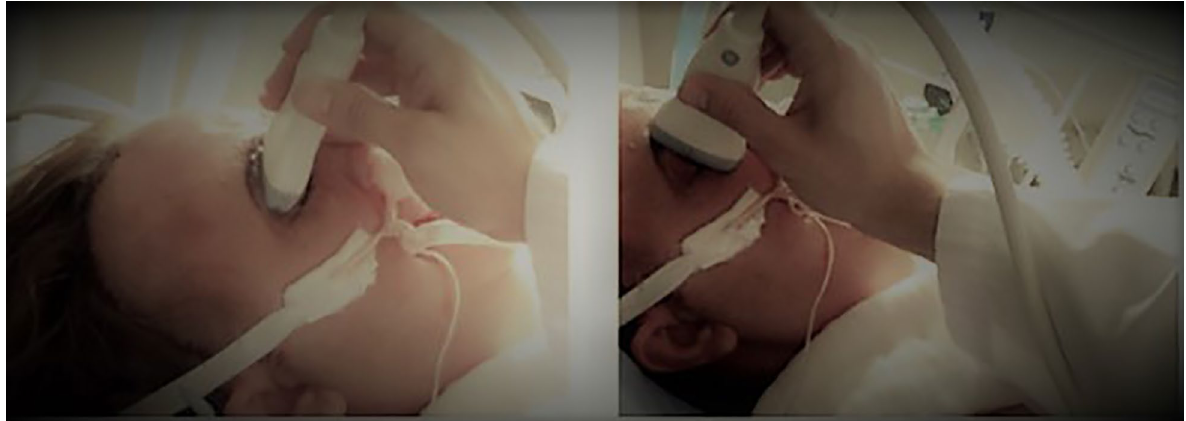
Fig. 2 On the left, transducer with transversal orientation for ONSD measurement. To the sagittal flat right with the transducer in the longitudinal